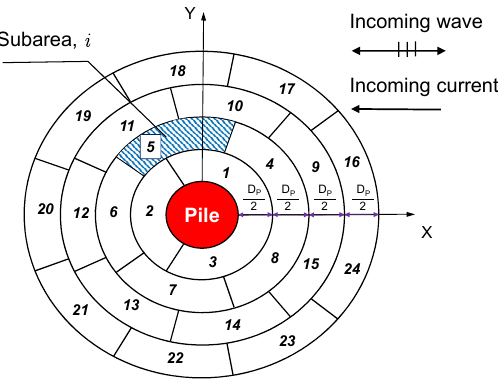
Figure 9. Subarea division of monopile scour protection armour layers.